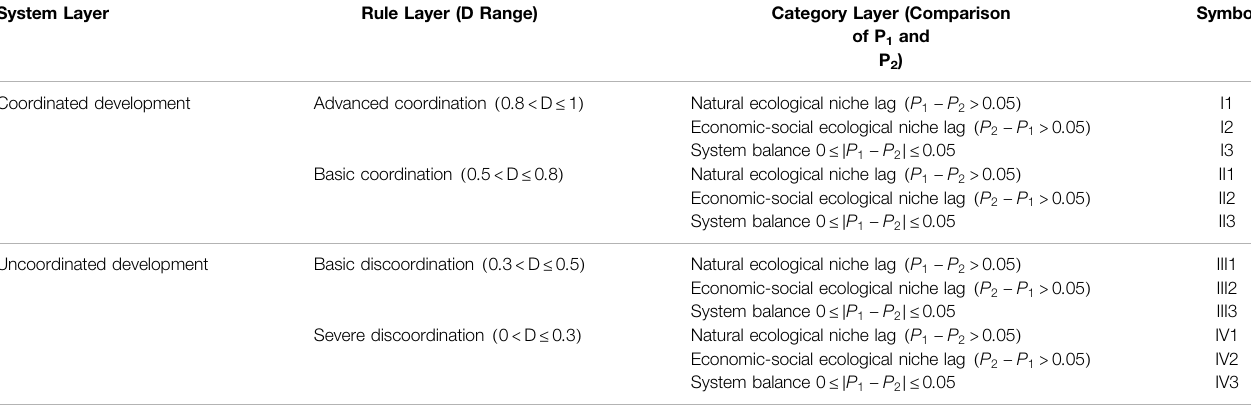
TABLE 2 | Classi fi cation of the stages of coupling coordination of economic-social-natural complex